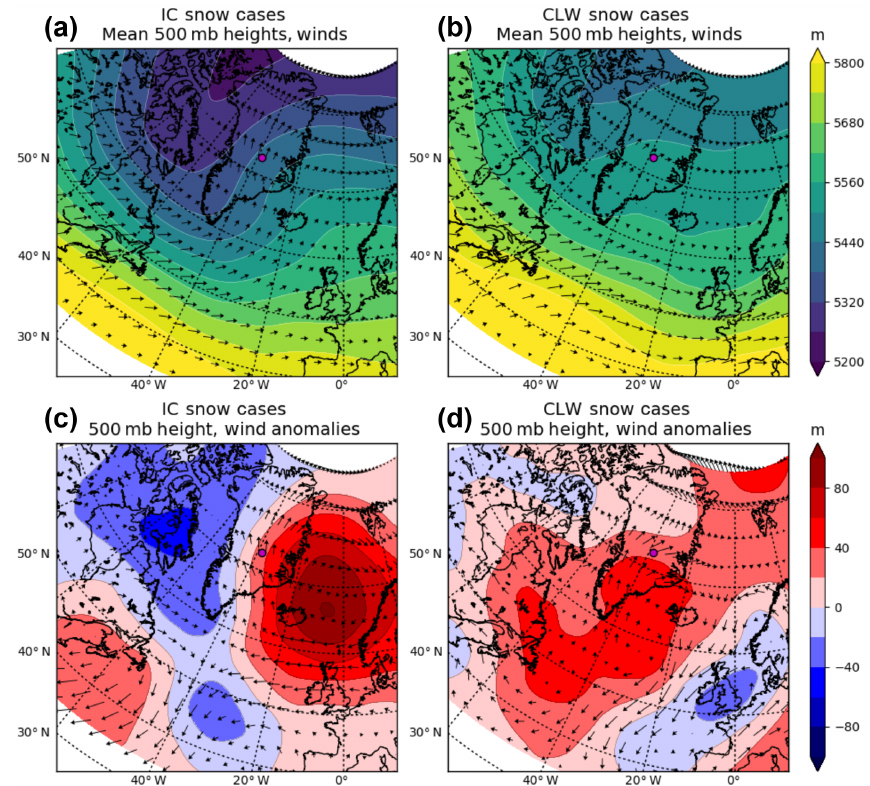
Figure 11. Panel (a) shows the ERA-Interim derived average 500mb geopotential heights and winds for 90 IC snow events. Panel (b) shows the same, but for 84 CLW snow events. Both plots are on the same scale. Panels (c, d) show the anomalies for the 500mb heights and winds for the respective cases. There is an incredibly strong trough and ridge feature in the IC snow cases. This feature indicates diverging upper-level winds just to the east of the trough, over the SE Greenland coast, which would induce strong vertical motions in the column and the upper level winds up show strong SE flow over the GIS. The CLW cases depict relatively calm and flat features, indicating quiescent flow of air up over the GIS from the S and